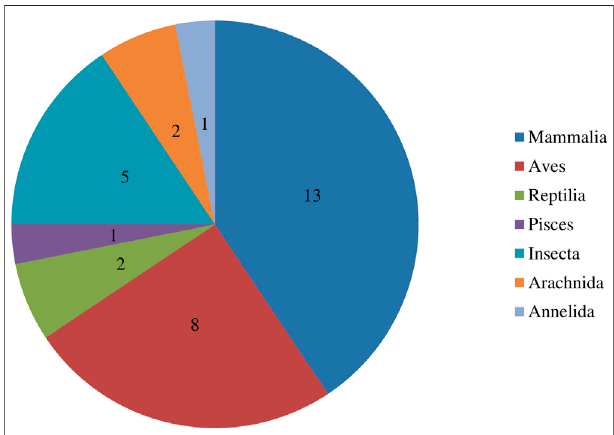
FIGURE 3 | Number of animal classes used in zootherapy practices by local communities.